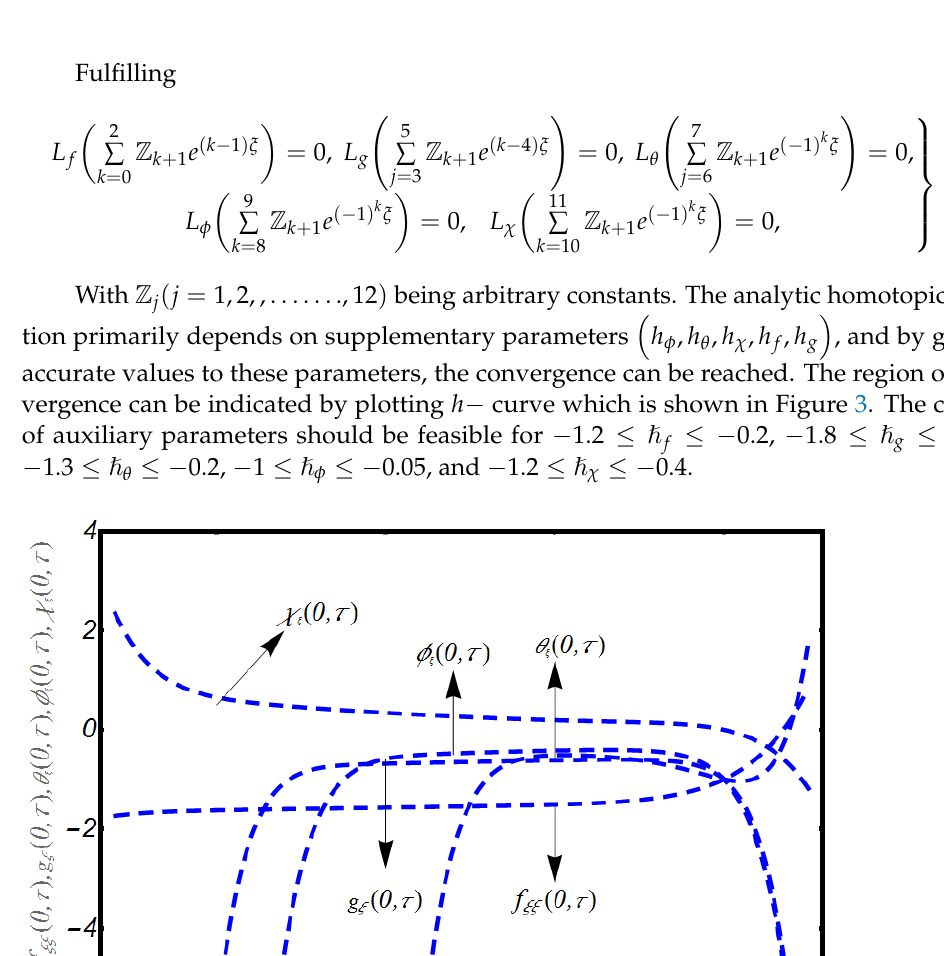
Figure 3. Curves for f , θ , φ , and χ .